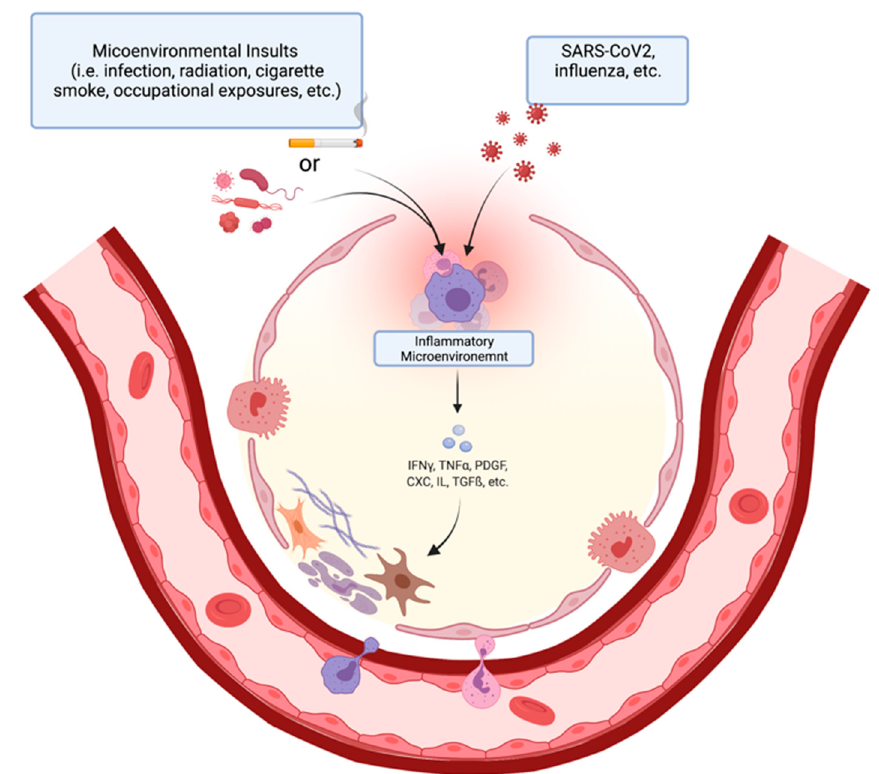
Figure 2. The onset and mechanism of fibrotic change in alveolar epithelium post microenviron- mental insult ( left ). Immune cells (purple, pink) in the inflammatory microenvironment secrete pro-fibrotic factors that stimulate collagen deposition by fibroblasts (brown). Flow diagram of steps of pneumocyte apoptosis and fibrosis initiation ( right ). (Created with BioRender.com, accessed on 1 April 2022).